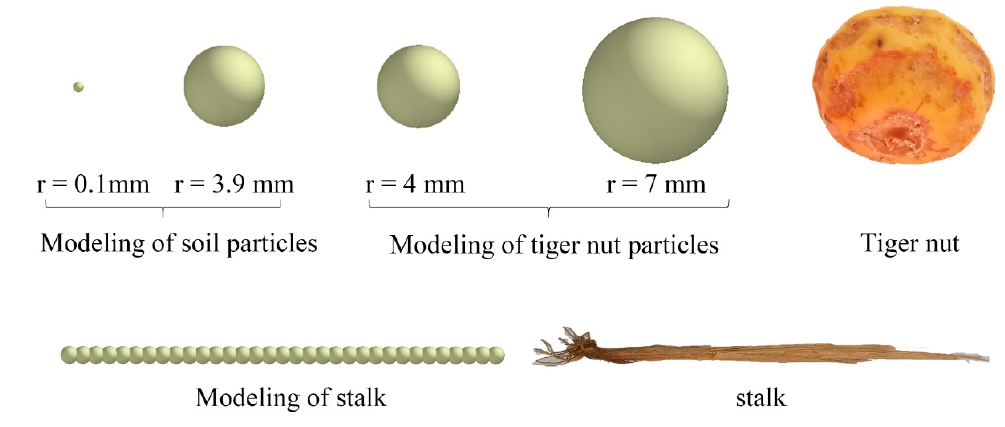
Figure 5. Models of tiger nut, soil particles and stalk. The model used a roller diameter of 250 mm and length of 1620 mm, upper sieve length of 3000 mm and width of 1650 mm; crushing guide roller diameter of 280 mm and length of 1630 mm, lower sieve length of 2450 mm and width of 1660 mm. All woven sieves are square sieves with 8 mm side lengths. The 3D model is imported into the EDEM software, as shown in Figure 6. Since in the simulation of the sieving process of the debris particle population, the focus is on the simulation and analysis of the particle motion and the sieve penetration process, the Hertz–Mindlin (no-slip) model is chosen for the numerical simulation process, assuming that the recovery coefficient and collision intensity of the debris particles do not change, and the effect of air resistance on the debris particles is ignored. According to the research results of the group and relevant references, the mechanical and contact parameters of the selected materials are shown in Table 1 [34–36].